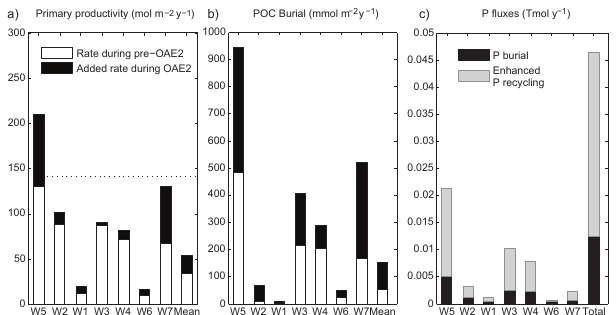
Fig. 8. Results for experiment E7 where ocean circulation is reduced to 70% and the Pacific bottom water has an oxygen concentration of 5µmolL − 1 (see black dot in Fig. 7) for (a) primary productivity, (b) POC burial, and (c) P burial and enhanced P recycling. As a ref- erence, the primary productivity and POC burial prior to OAE2 are shown for each region. Mean refers to the area-weighted mean for the proto-North Atlantic. The dashed line in (a) represents the mean primary productivity in modern upwelling areas. The enhanced P recycling flux is calculated as the reduction in P burial due to in- creased anoxia following Eqs. (7), (9) and